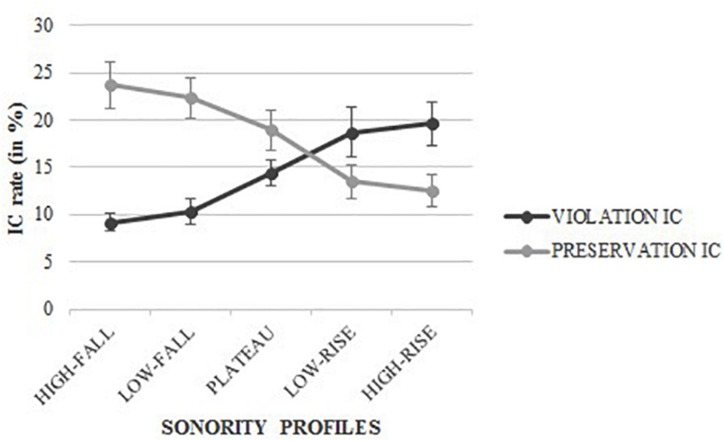
Illusory conjunction rate (IC) in percentage (%) for the Condition × Sonority interaction.